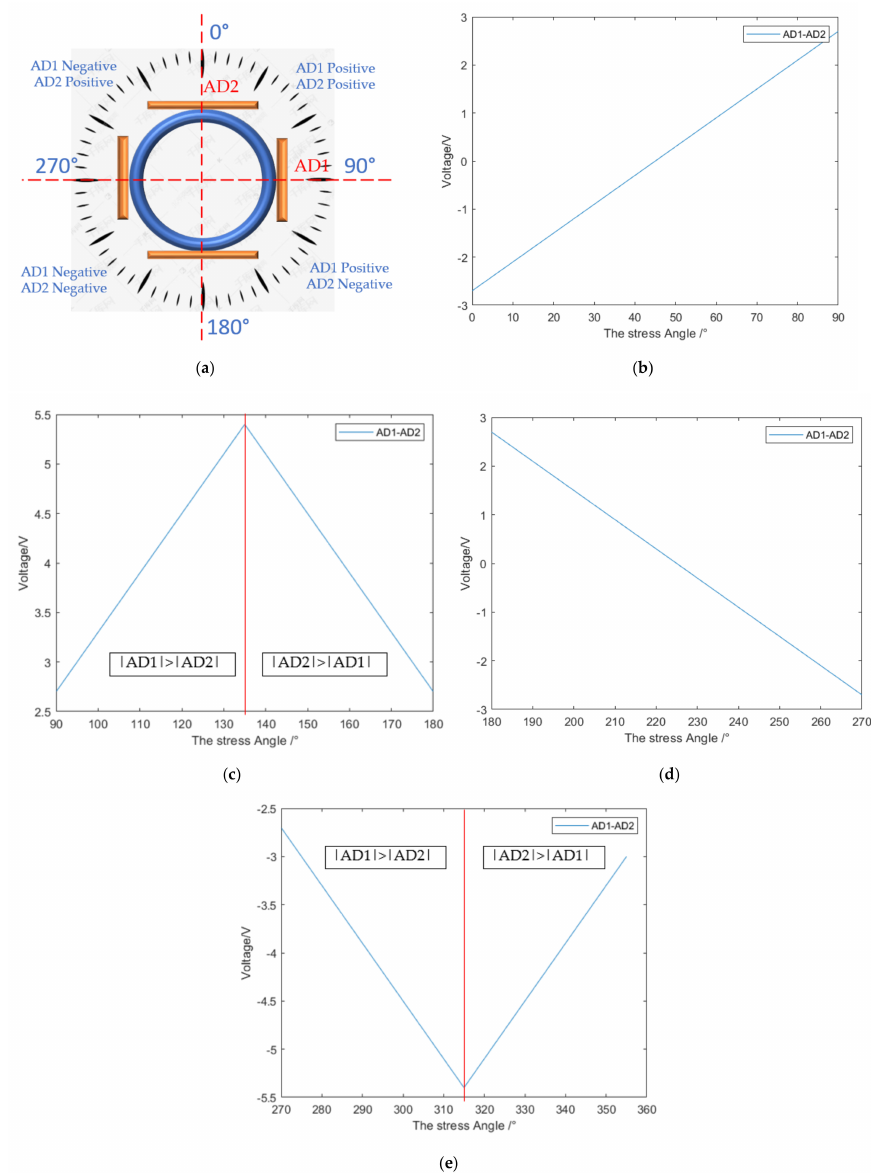
Figure 16. ( a ) The division of the force angle of the catheter; ( b ) 0–90 degree correspondence; ( c ) 90–180 degree correspondence; ( d ) 180–270 degree correspondence; ( e ) 270–360 degree